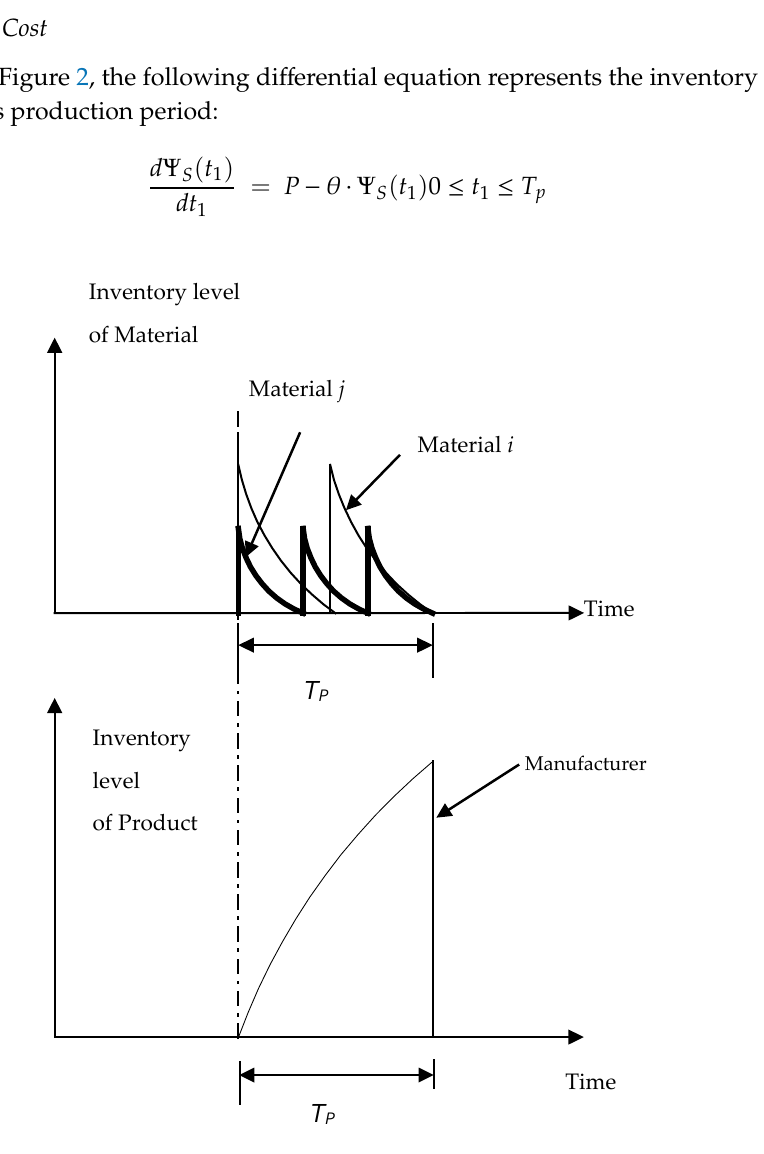
Figure 2. Manufacturer inventory system for deteriorating items in a single-period production–inventory model (PIM).